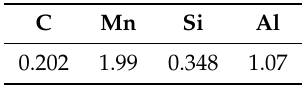
Table 1. Chemical composition of CR-TRIP700 in wt